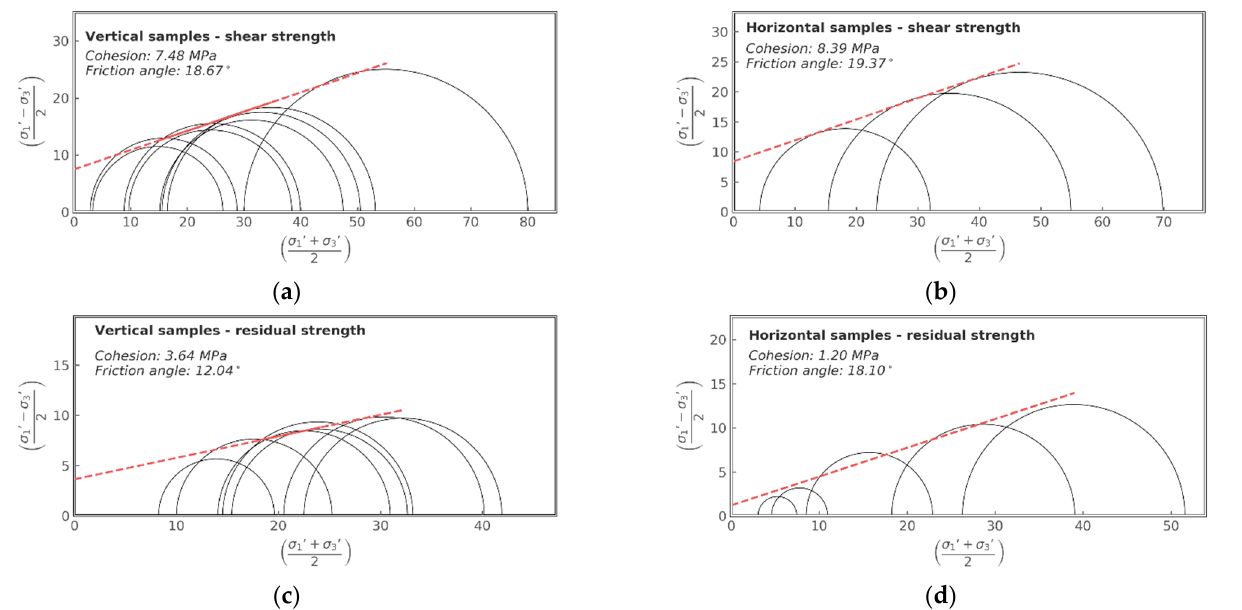
Figure 11. The intact ( a , b ) and residual ( c , d ) apparent cohesion and friction angle from undrained triaxial testing on vertical ( left ) and horizontal ( right ) samples of Draupne shale.